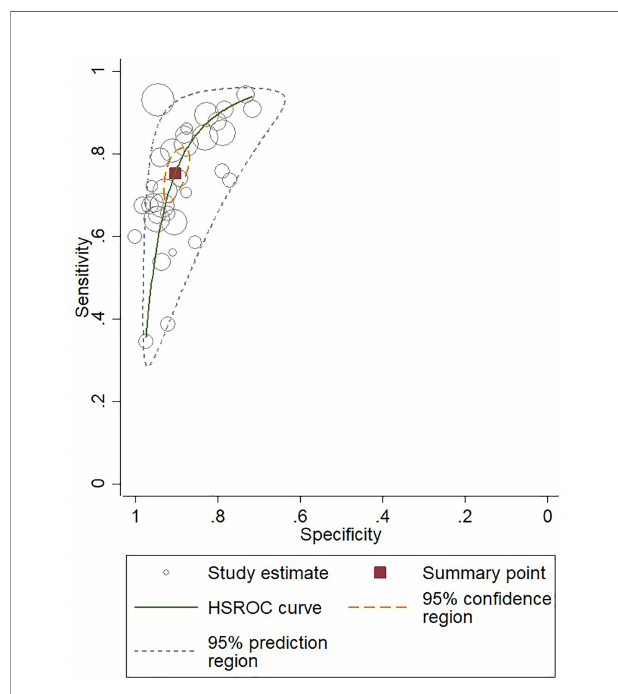
FIGURE 4 | SROC curve for gadoxetic acid-enhanced MRI for HCC diagnosis. SROC, summary receiver operator characteristic curve; HCC, hepatocellular carcinoma.